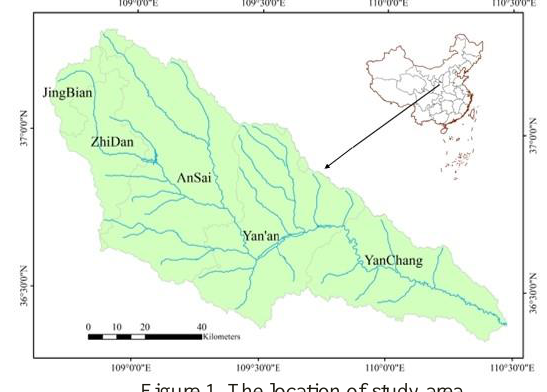
Figure 1. The location of study area.